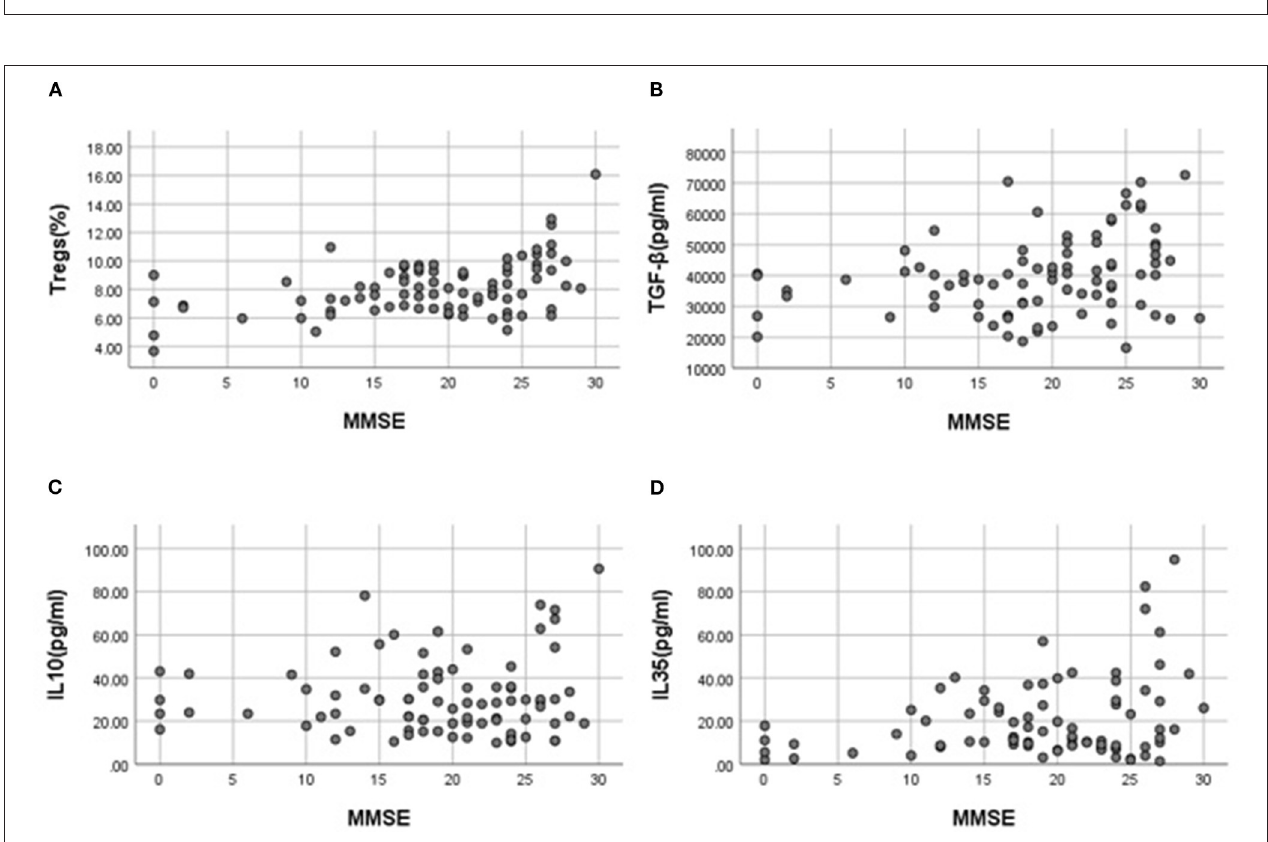
FIGURE 1 | Error bar charts show the difference in mean ± standard error of the mean (SEM) values of regulatory T cells (Tregs) and transforming growth factor β (TGF- β ) in peripheral blood of healthy control (HC), mild cognitive impairment (MCI), mild Alzheimer’s Disease (AD) dementia, and moderate-to-severe AD dementia